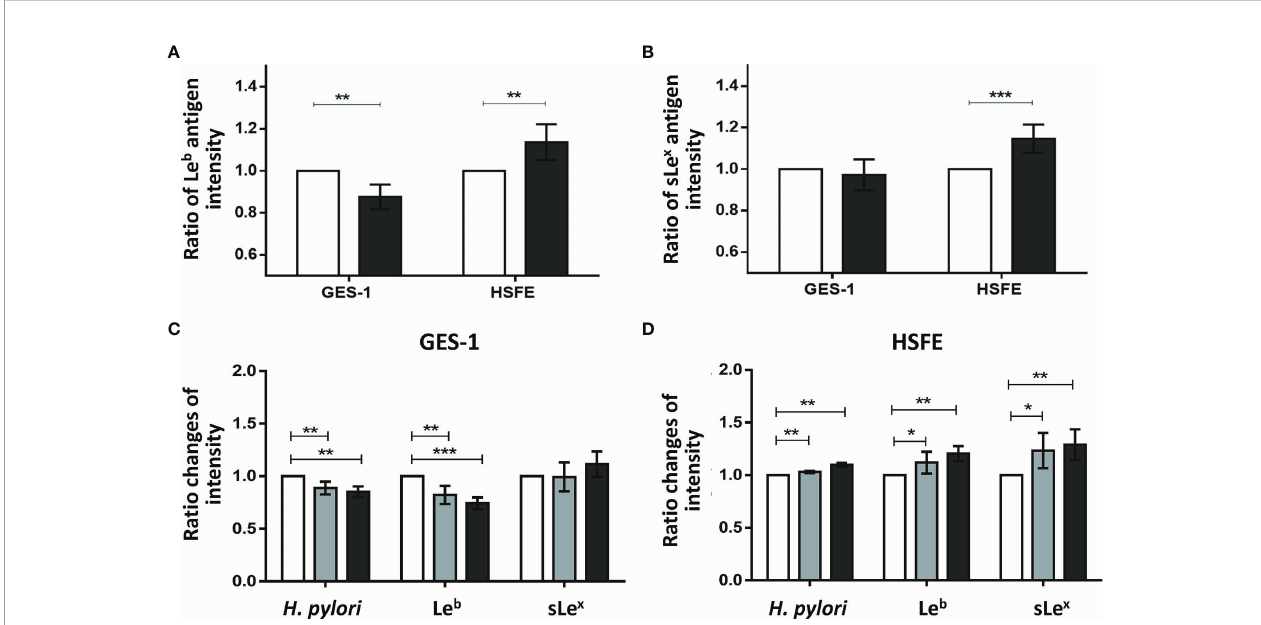
FIGURE 6 | The impact of p-JNK activity on the intensity of Lewis antigen expression in GES-1 and HSFE cells. GES-1 and HSFE cells were transfected with JNK (black) and negative control (white) siRNA 10 r g with 8 m l RNAi MAX Lipofectamine. The cells were challenged with H. pylori (MOI 100) for 1 hour. The intensity of (A) Le b and (B) sLe x antigen expressions were detected using speci fi c antibodies by fl ow cytometry. Pretreatment with a p-JNK inhibitor in (C) GES-1 and (D) HSFE cells at different doses (0, white; 12.5 m M, gray; 25 m M, black) for 1 hour. The cells then were co-cultured with H. pylori (MOI 100) for 1 hour. The intensity of H. pylori colonization, Le b , and sLe x antigen expressions were detected using speci fi c antibodies by fl ow cytometry. Data are expressed as means ± SD (in triplicate). Statistical analysis was performed with each measurement with comparisons to the negative control. (* P < 0.05, ** P < 0.01, *** P <